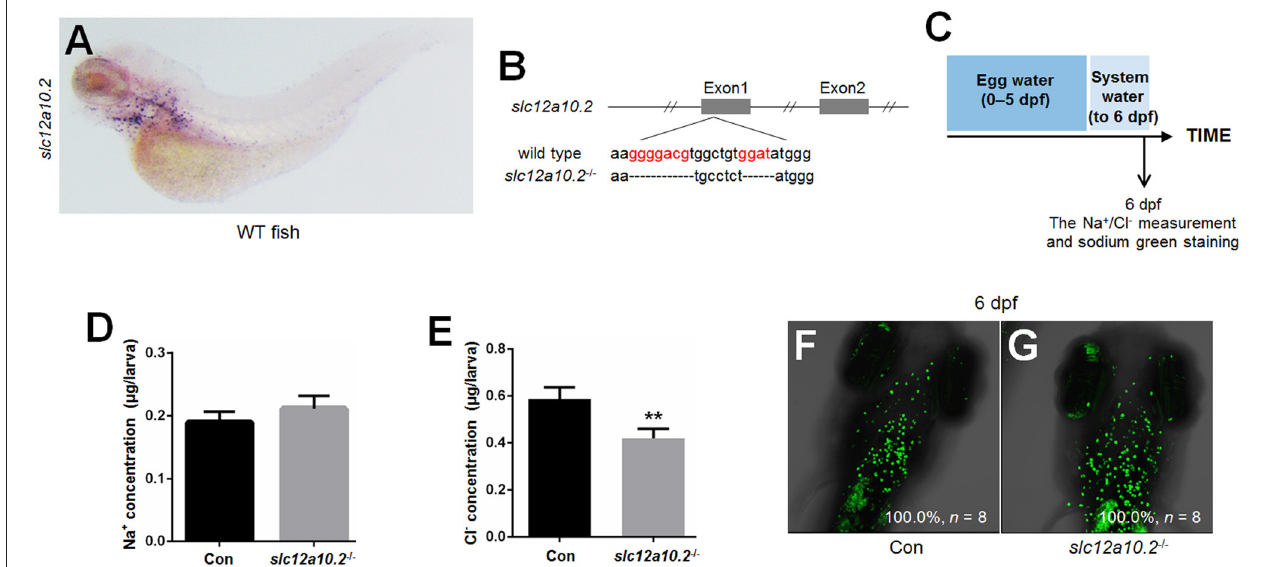
FIGURE 1 | Generation of slc12a10.2 -deficient zebrafish. (A) WISH analysis using the slc12a10.2 probe in wild-type larvae at 4 dpf. (B) Targeted depletion of the slc12a10.2 gene. The CRISPR/Cas9 target site is located at exon 1. A genotype with an 11-bp deletion was used to establish the slc12a10.2 knockout line (highlighted in red). (C) Schematic diagram of the rearing timeline. Larvae were reared in egg water from 0 to 5 dpf and in system water after 5 dpf. The fish at 6 dpf were harvested for Na + and Cl − measurements. (D,E) Na + and Cl − concentrations were measured in control and slc12a10.2 -deficient larvae at 6 dpf. ** P < 0.01. (F,G) Sodium green staining in the gills of control and slc12a10.2 -deficient larvae at 6 dpf (ventral views).